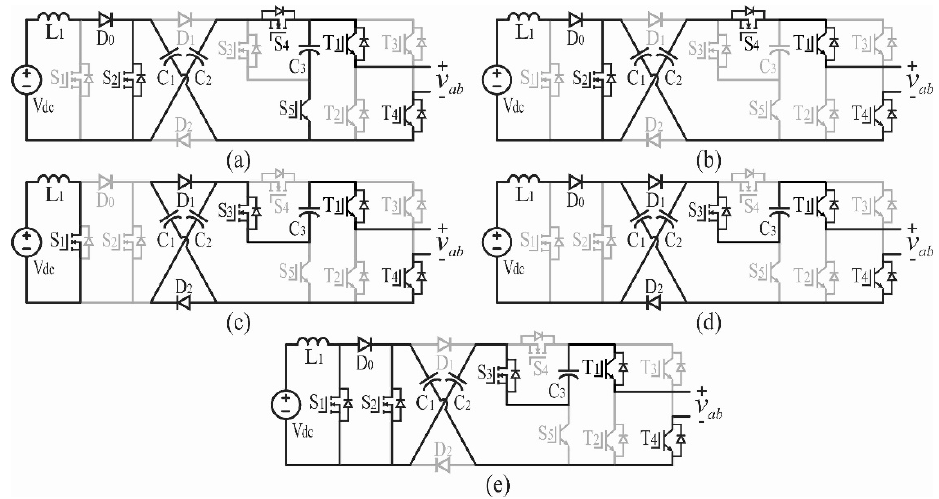
Figure 4 . Operation states in the positive output voltage period of the proposed NLBI (continuous). ( a ) State 5, ( b ) State 6, ( c ) State 7, ( d ) State 8 and ( e ) State 9.